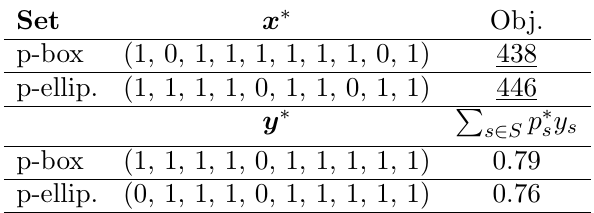
Table 2. Uncertainty parameter re- alizations with probabilities